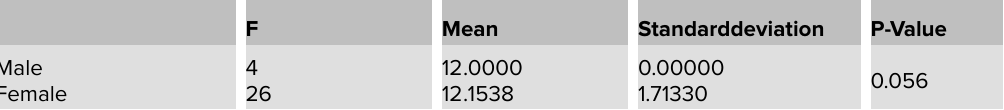
TABLE 3: Pre–posttest association between students’ demographic data and knowledge ( n =30). F Mean Standarddeviation P-Value 4 Female